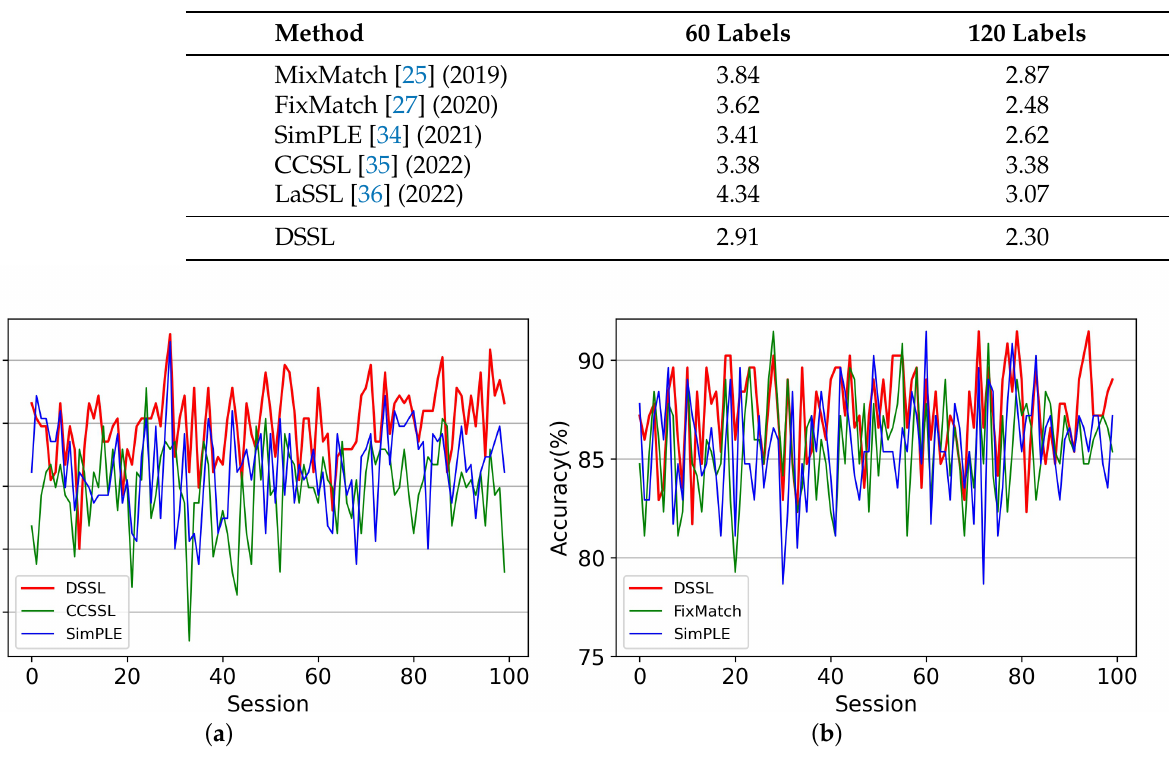
Figure 6. Illustrating ( a ) line graphs of the three methods with a minor variance in the results of 100 experiments in the 60-label case and ( b ) line graphs of the three methods with a minor variance in the results of 100 experiments in the 120-label